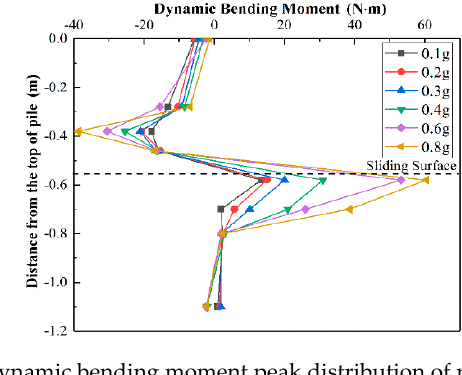
Figure 15. Dynamic bending moment distribution of each row of pile (shaking table test).